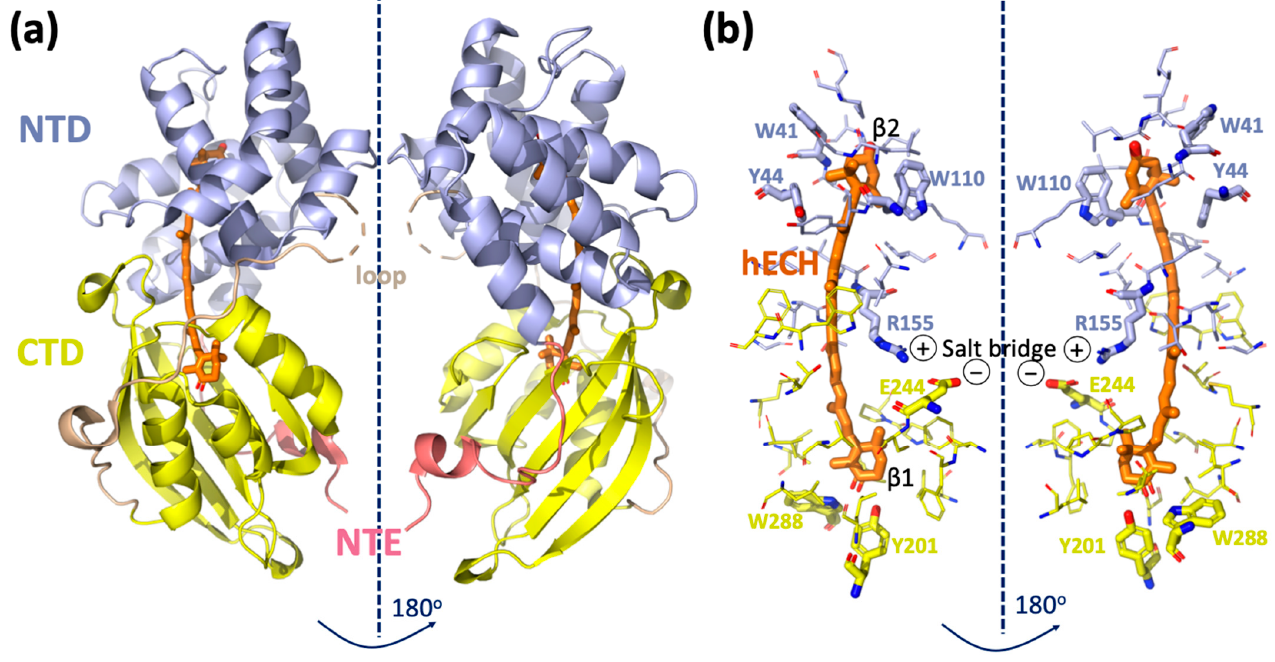
Figure 1. Structure of Orange Carotenoid Protein. ( a ) Crystal structure of Synechocystis sp. PCC6803 OCP (PDB ID code 5TV0) consisting of two domains, NTD and CTD, NTE and the loop as described in the main text introduction. ( b ) Amino acid residues within 4.5 Å of the carotenoid are shown by sticks.